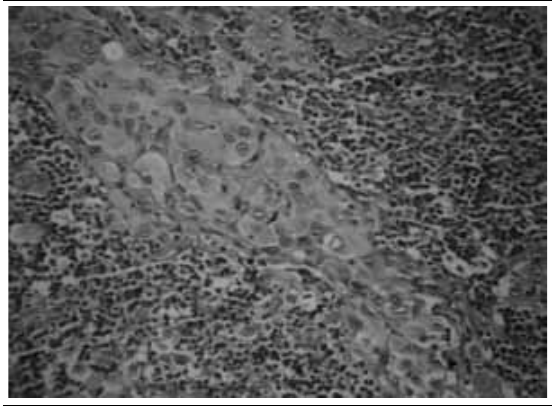
figurE 6 – Pulmonary HEE (HE, 20×) Proliferation of epithelioid neoplastic cells in the pulmonary parenchyma. It is possible to observe alveolar spaces with reactive pneumocytes. HEE: epithelioid hemangioendothelioma; HE: hematoxylin and eosin.